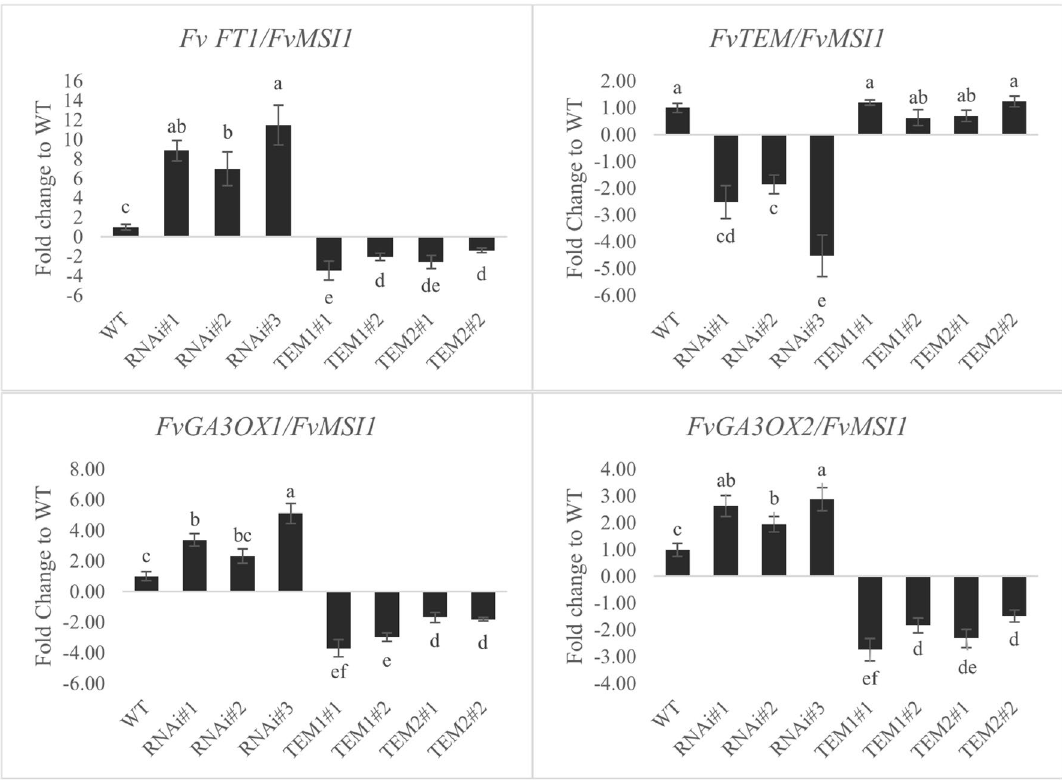
Figure 5. Relative expression of FvFT1 , FvTEM , FvGA3ox1 and FvGA3ox2 genes in overexpressing and silencing H4 lines. The mean data are obtained from three biological and three technical replicates, all normalized to the expression level of FvMSI1 . Samples were collected at ZT 8. Plants were raised in the growth chamber at 25 °C under 16/8 h light/dark photoperiod. Error bars indicate standard errors. Means were compared by LSD test and different letters show a significant difference at p ≤